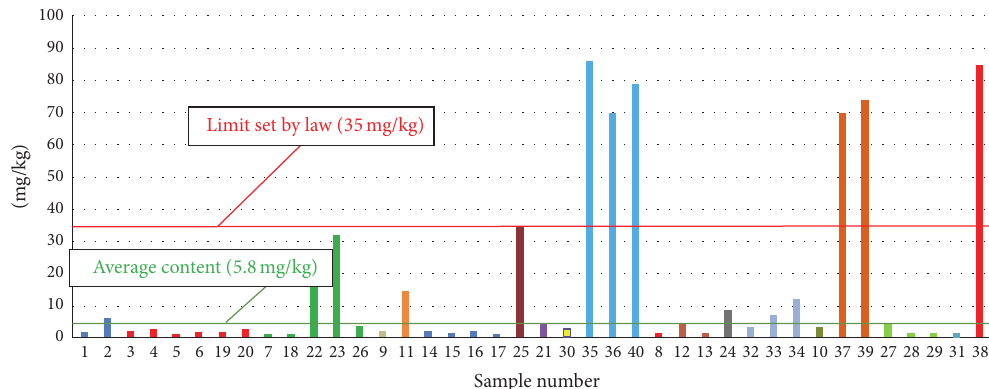
Figure 2: Distribution of fatty acid ethyl esters in samples grouped by zone of production. Samples sharing the same origin are grouped by colour. Values of aged EVOOs are not accounted in the average